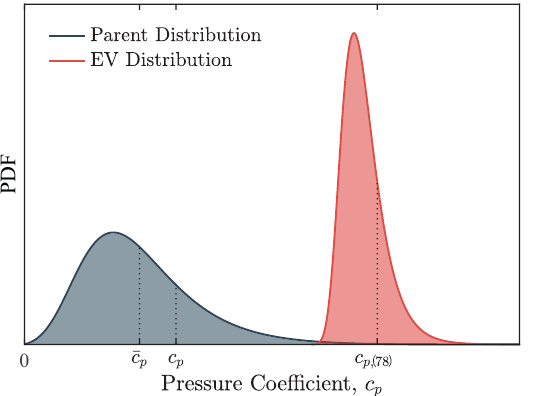
Figure 2. Sketch of the parent and EV distributions of the pressure